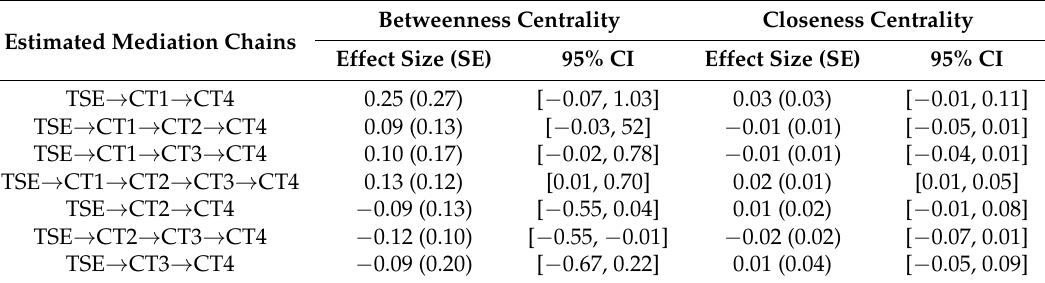
Table 2. Overview of the mediation effects estimated in our analyses.